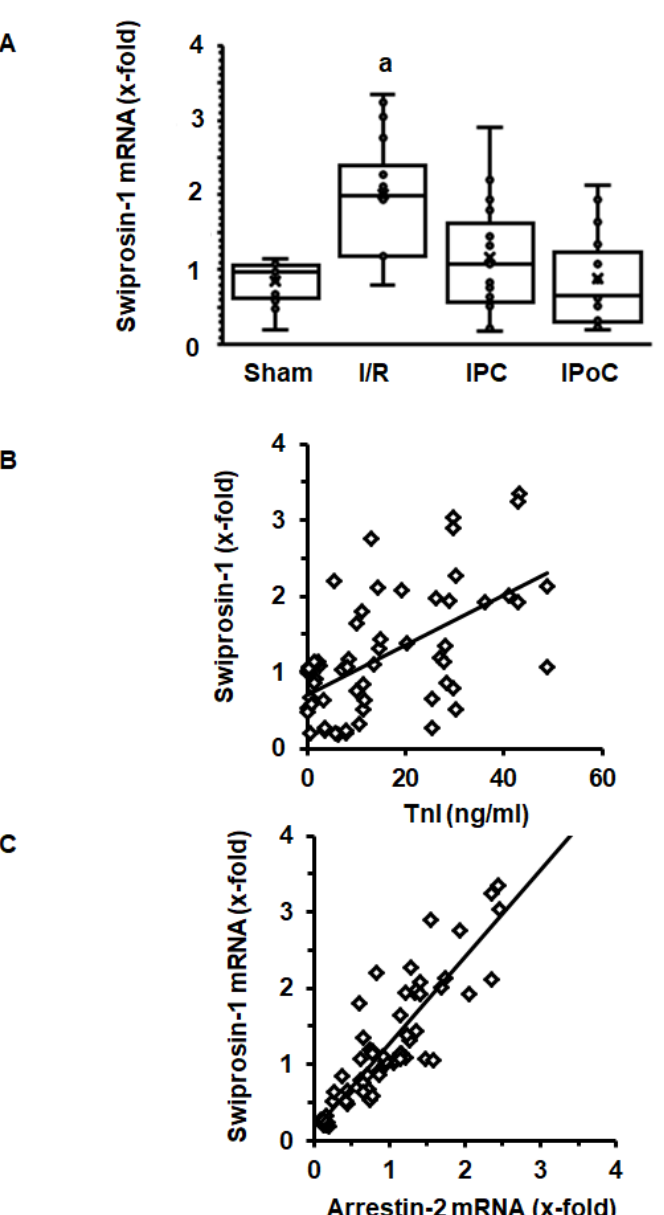
Figure 2. Expression of swiprosin-1 mRNA in the left ventricle from rats seven days after I / R. ( A ), Box plots showing the level of expression and distribution of samples from sham surgery (Sham), ischemia / reperfusion (I / R), ischemic preconditioning (IPC), and ischemic postconditioning (IPoC). Data are analyzed by One-Way-ANOVA with Student–Newman–Keuls post-hoc analysis (a; p < 0.05 vs. all other groups). ( B ); Correlation between infarct sizes as quantified by troponin I release into the plasma 60 min after reperfusion and swiprosin-1 mRNA expression. ( C ) Correlation between arrestin-2 mRNA expression and swiprosin-1 mRNA expression.